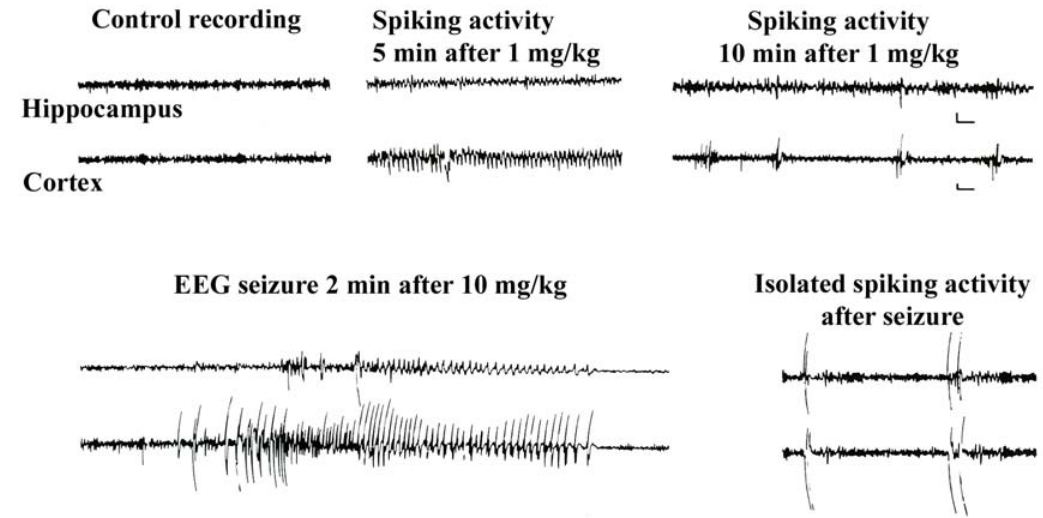
FIGURE 1. Beta-CCM–induced seizures: electroencephalographic data. With a dose of 1 mg/kg, i.p., no seizure occurred, but mild spiking activity could be observed in both the cortex and hippocampus. With a dose of 10 mg/kg, i.p., pronounced spiking activity was observed during the seizure, followed by occasional spikes during the postictal period. (Adapted from Prado de Carvalho et al.[32].)